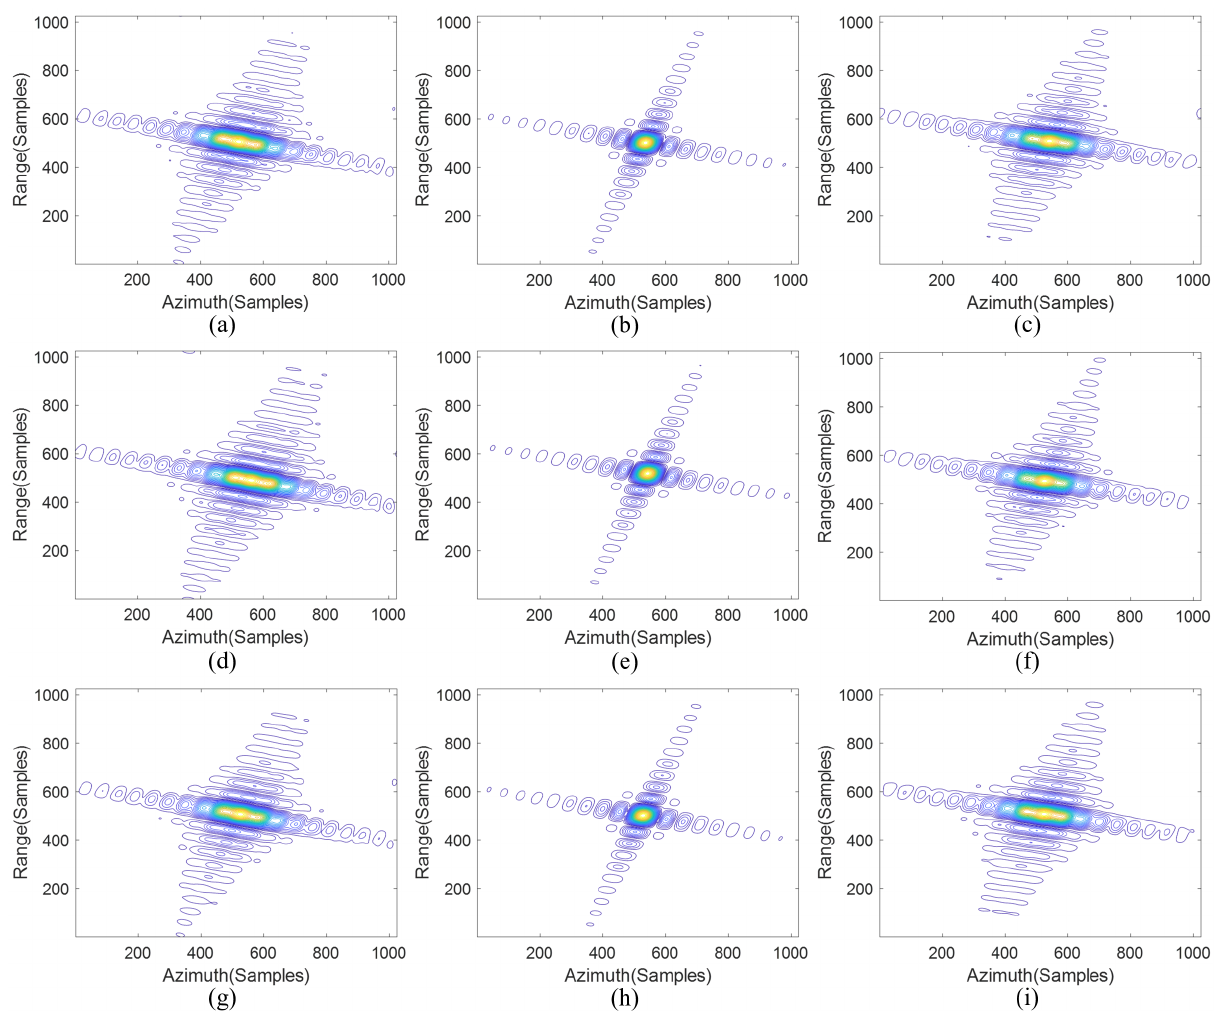
Figure 6. Real-time imaging results of modified OSA with MCRM. ( a – c ) Results of targets 1–3.